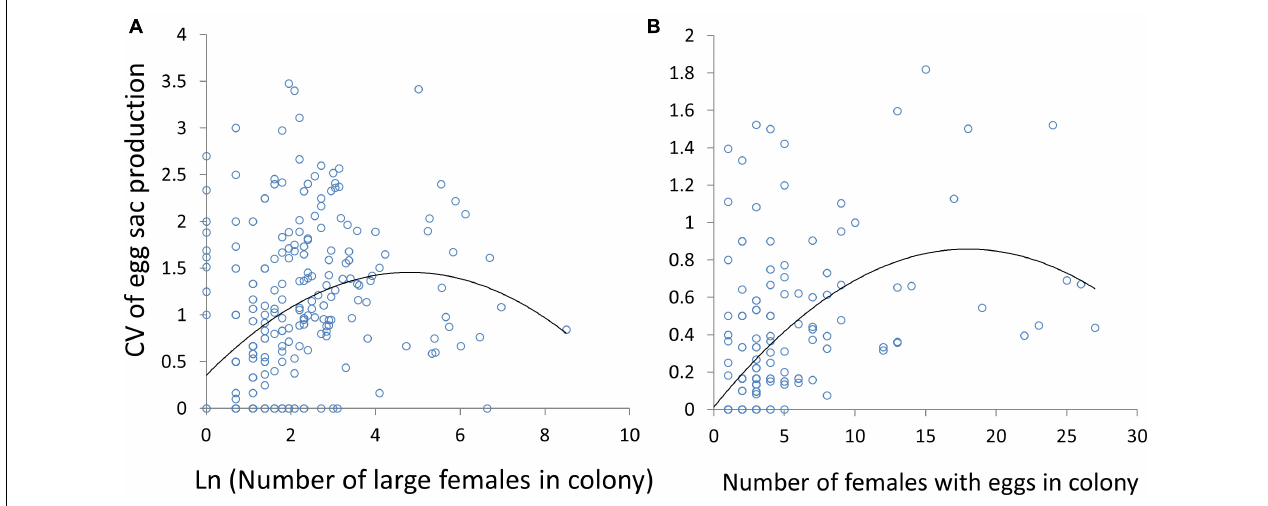
FIGURE 8 | The relationship between the coefficient of variation (CV) of egg sac production within colonies and colony size, measured as the total number of large females in panel (A) and only females with egg sacs (B) . CVs for singletons were derived from all singletons within a site. Significant quadratic effects are shown in solid black